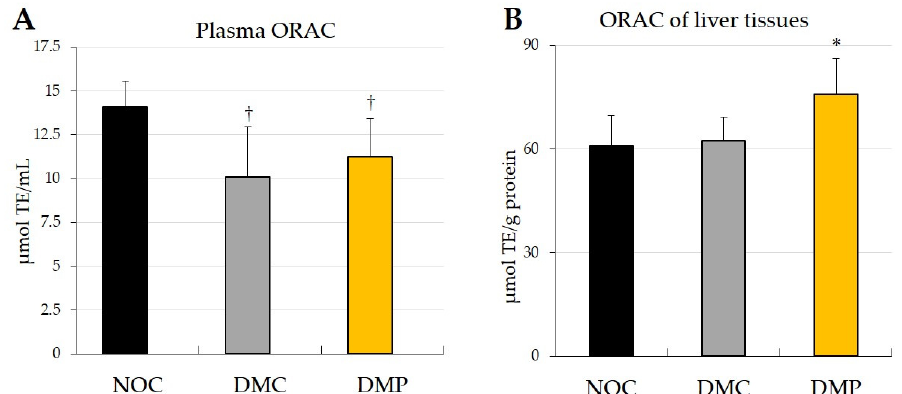
Figure 3. Effects of non-extractable fraction of dried persimmon (NEP) on the ORAC of plasma ( A ) and liver tissues ( B ) after 9 weeks in normal and diabetic rats. NOC: normal rats fed a control diet, DMC: diabetic rats fed a control diet, DMP: diabetic rats fed NEP diet. Data are presented as the means ± SD of each animal in each group. † p < 0.05 significantly different from the NOC group. * p < 0.05 significantly different from the NOC and DMC groups.